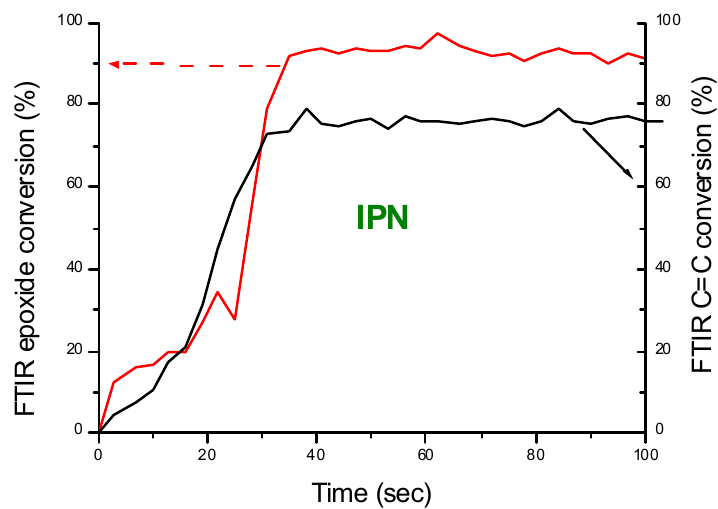
Figure 35. RT-FTIR monitoring of the polymerization of an EPOX / methacrylate mixture (1,4-BDMA / HPMA / UDMA) blend under air using the four component system (Cu(Oct) 2 / BPO / Vit-C / Iod (0.75% / 1.1% / 1.5% / 1%, w / w / w / w ) with and without light irradiation at 405 nm. Reproduced with permission from the authors of [68]. Copyright 2018 The American Chemical Society.